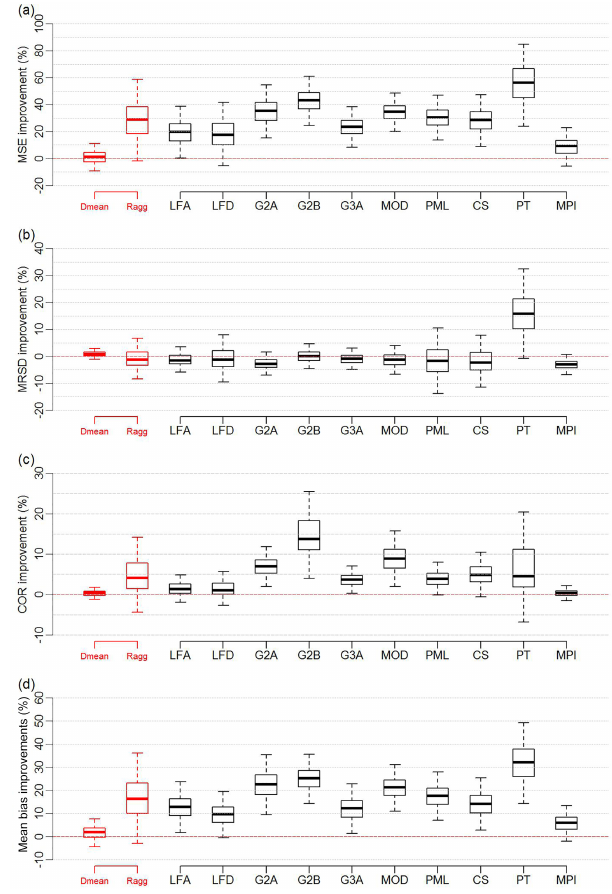
Figure 3. Box and whisker plots displaying the percentage improve- ment that the weighted product provides in the 25% out-of-sample sites test for four metrics: MSE (a) , MRSD (b) , COR (c) and mean bias (d) , when compared to the equally weighted mean of the di- agnostic ensemble ( D mean ), aggregated reference ensemble ( R agg ) and each member of the reference ensemble. Box and whisker plots represent 5000 entries; each entry is generated through randomly selecting 25% of sites to be out of